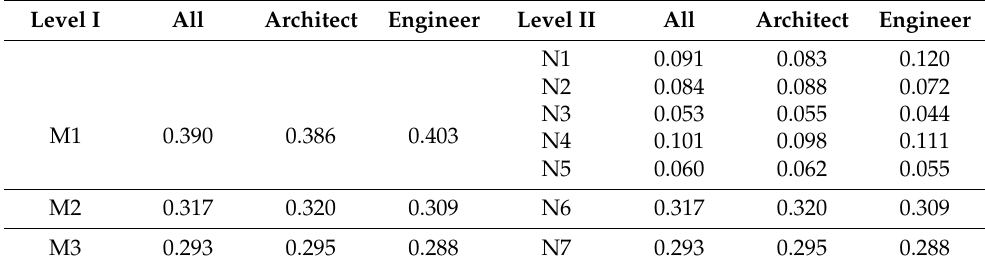
Table 8. Weighting coefficients of ATI provided by different